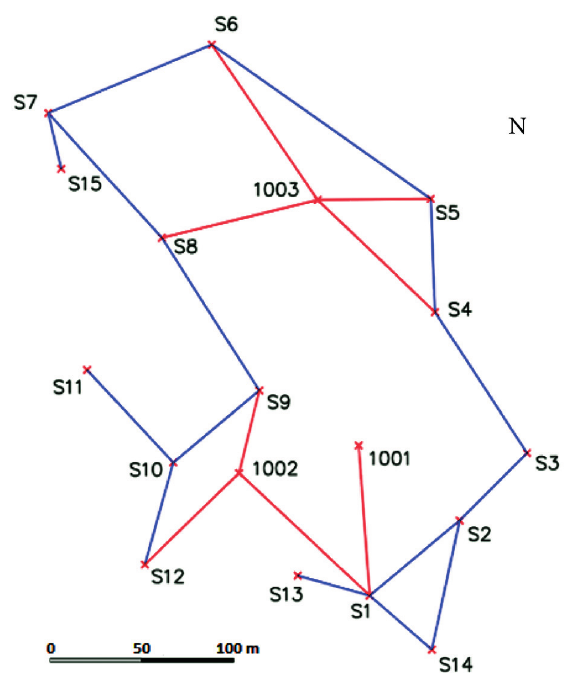
Fig. 5. The survey network in the semi-coke landfill ash-hill. Notes: S1 to S15 denote locations of TLS survey stations, whereas 1001 to 1003 denote locations of the HDS targets. Blue lines indicate orientation measurements between TLS survey stations. The red lines indicate scanning sights towards HDS